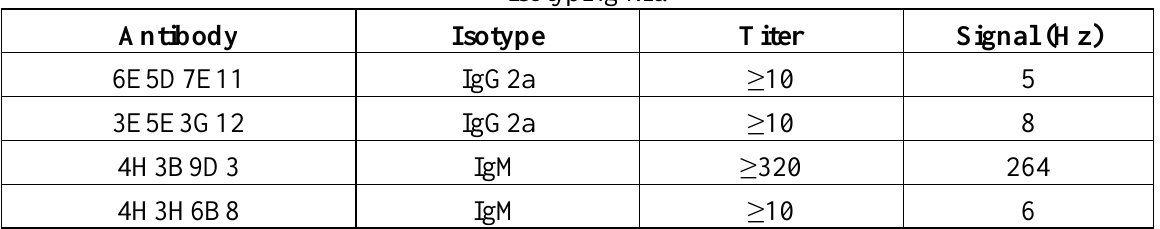
Tab. 1. Selection of monoclonal antibodies against F. tularensis from the best producing